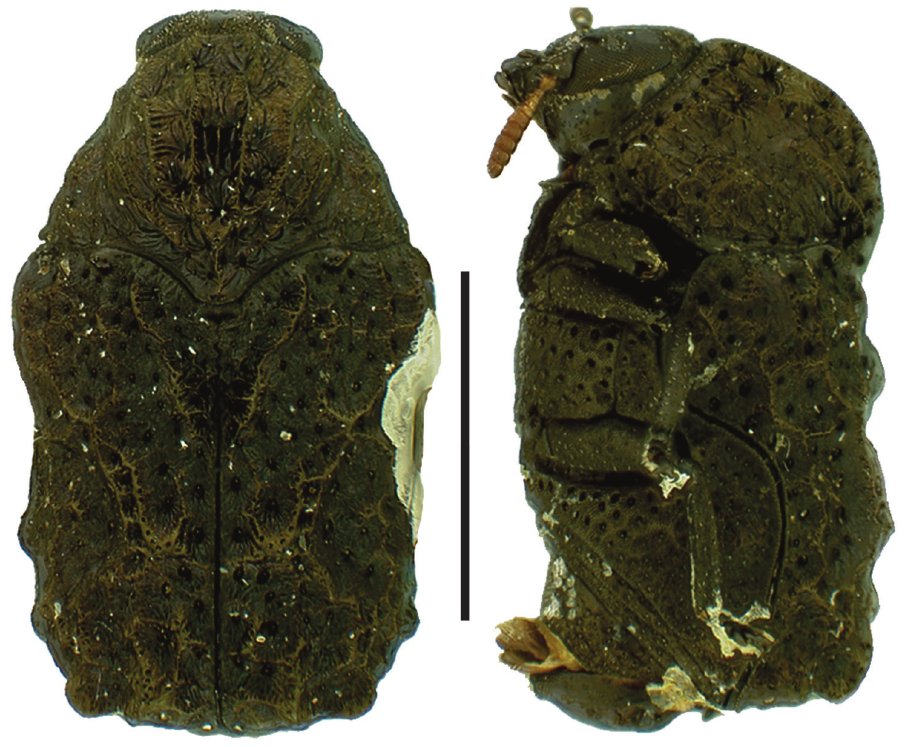
Figure 28. Aulacochlamys costicollis (Lacordaire) (2) , left: habitus (dorsal view), right: habitus (lateral view).